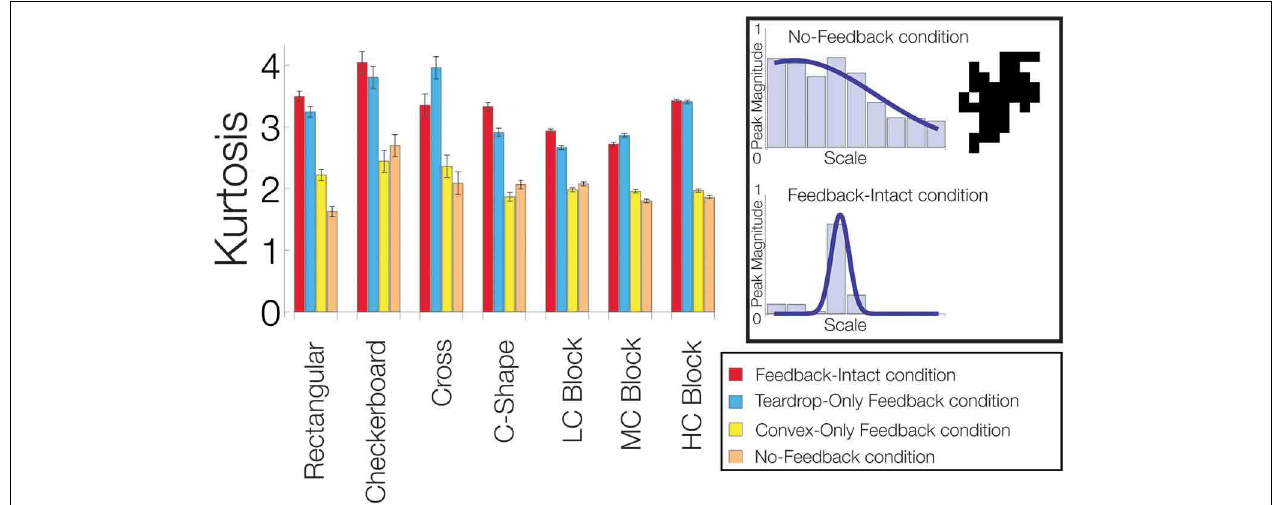
FIGURE 11 | Feedback improves the model’s sensitivity to the medial axis of the figure. For each visual display set, the kurtosis of the distribution of the most active convex cells with different RF sizes is plotted. An example of a low kurtosis distribution of most active convex cells with different RF sizes is shown on the top-right panel. The bottom-right panel shows a distribution with a high kurtosis. We compared performance when feedback from the convex cell recurrent circuit was lesioned (blue, Teardrop-Only Feedback condition), when feedback from